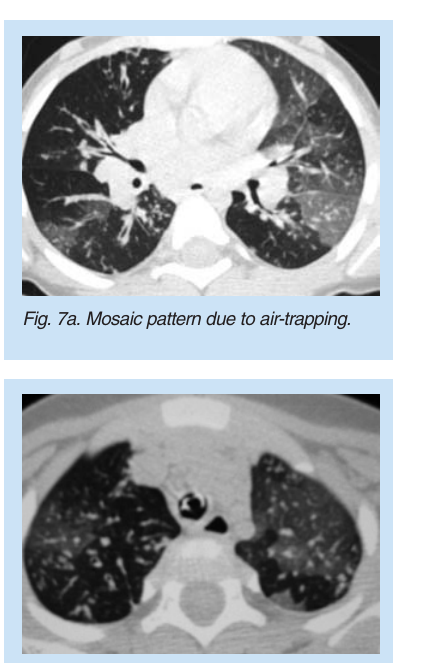
Fig. 7b. Mosaic pattern due to focal areas GG.